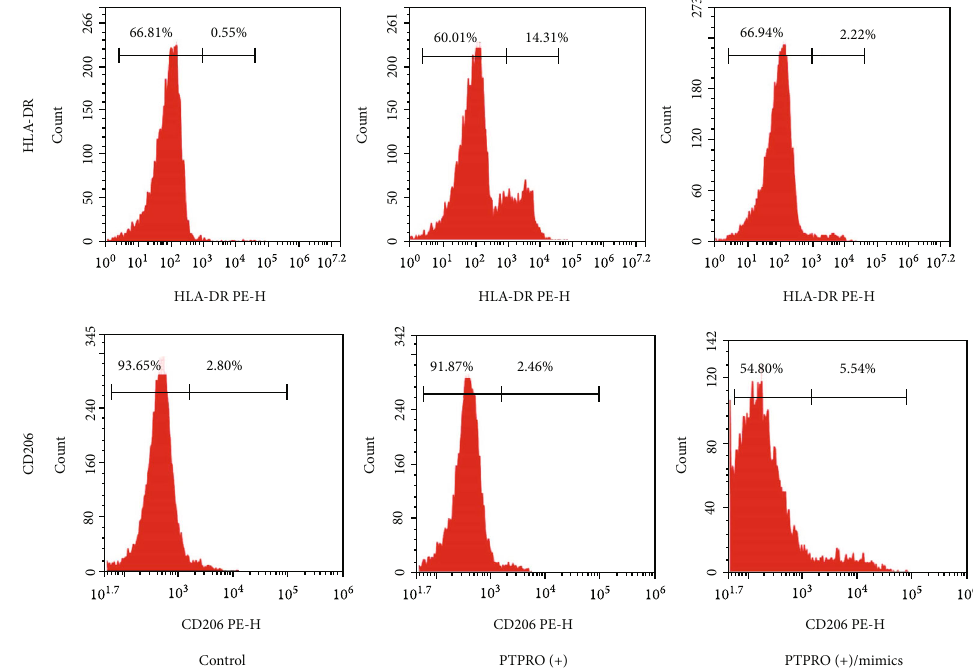
Figure 5: MiR-6869-5p promoted macrophages polarization towards